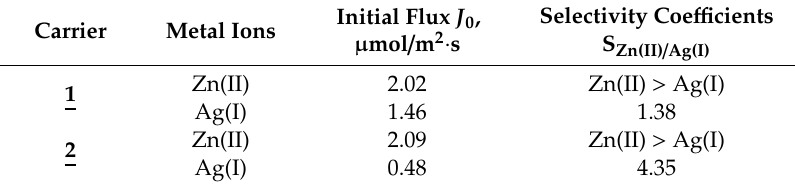
Table 3. The values of parameters characterizing Zn(II) and Ag(I) transport across PIM doped with alkylimidazole; membrane: pH of the feed phase was 6.5, receiving phase was 0.01 M HNO 3 .